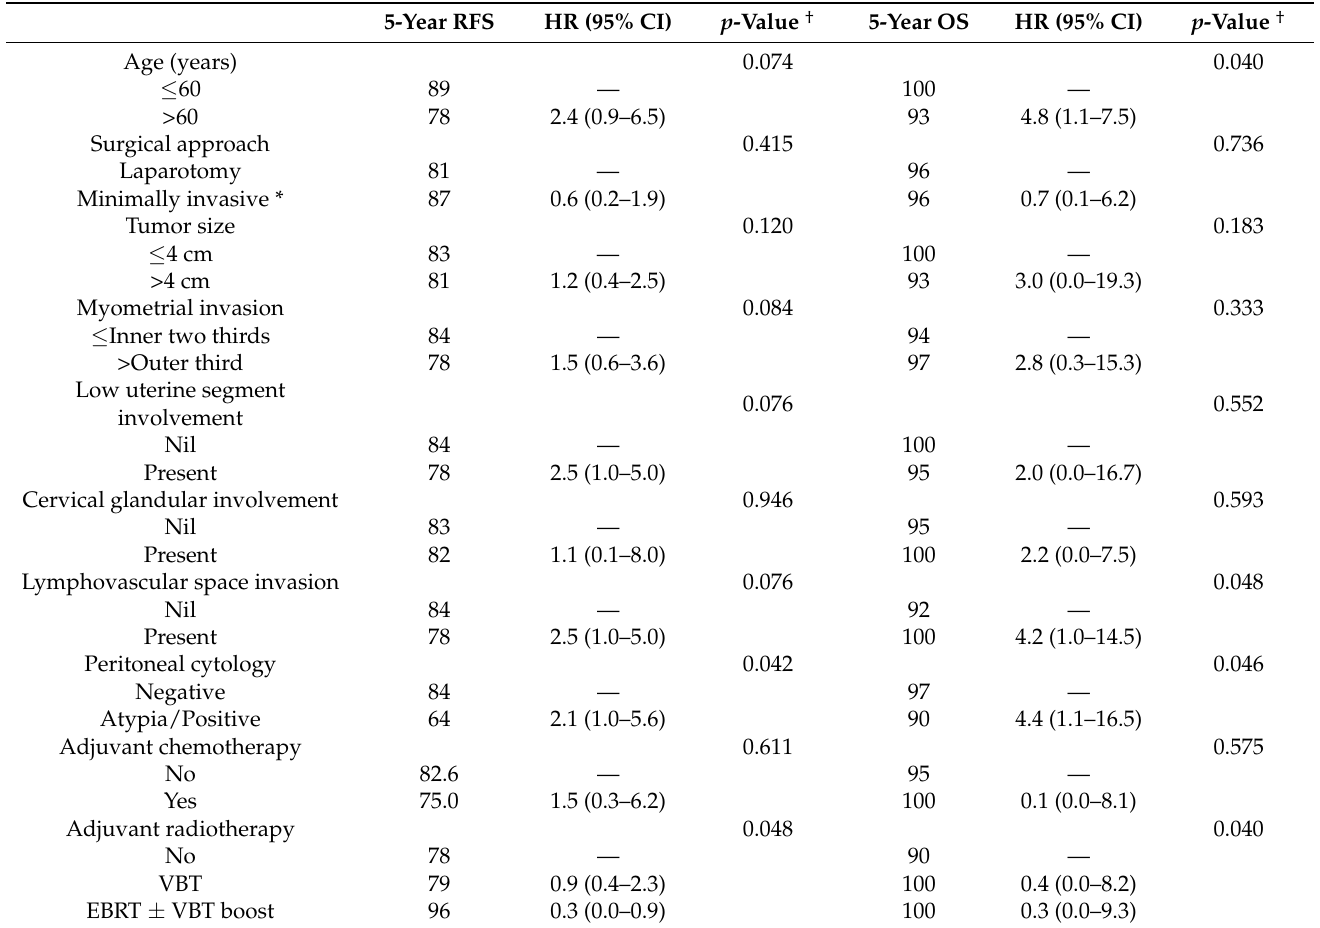
Table 2. Parameter analysis of potential prognostic factors in IB grade 1–2